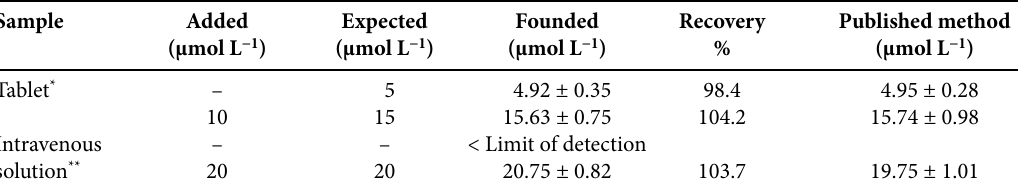
Table 3. Determination of 6-TG in real samples ( n = 5) Sample